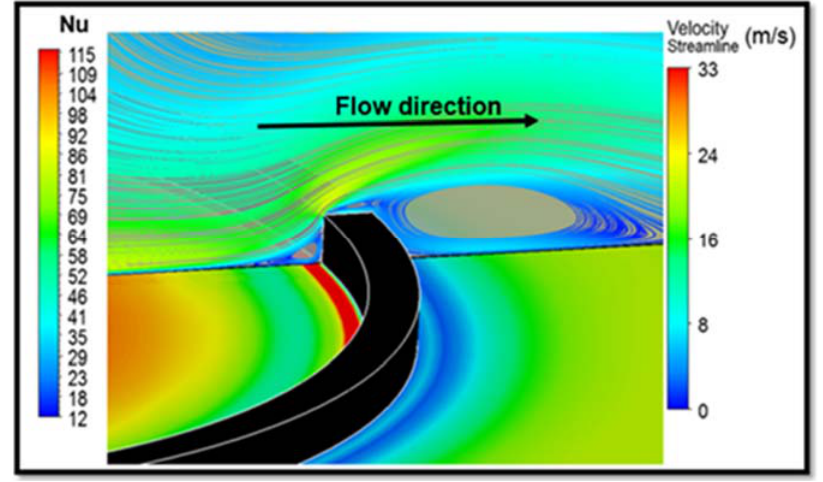
Figure 11. Velocity streamlines and local N (cid:2931) contours for R/D = 2.0 and e = 1.25 mm.